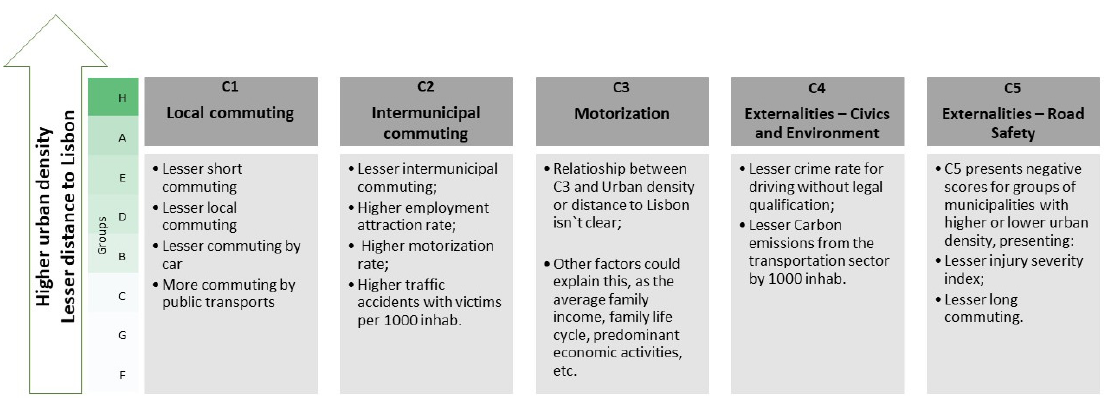
Figure 7. Relation between PCA components and clusters according to urban density and distance to Lisbon.